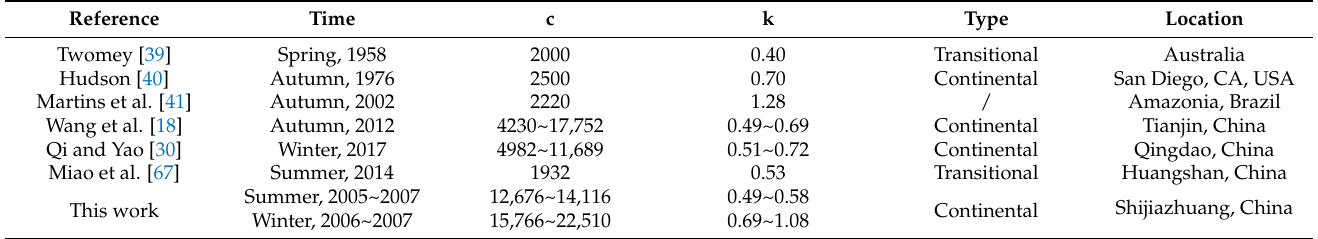
Table 3. Comparison of parameters c and k from multiple studies. The type of CCN is determined according to Hobbs et al.